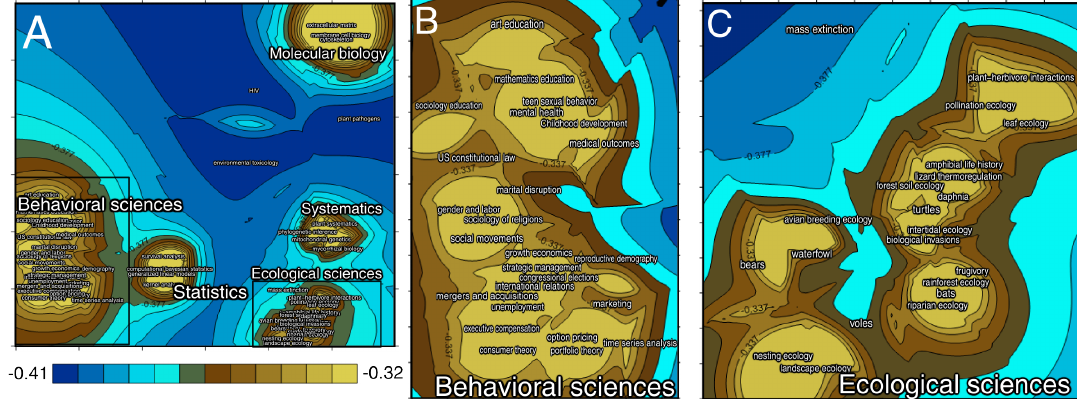
Figure 3: Topographical map of science combining textual and citation data. Fields that are close communicate frequently: positions in space are calculated by applying principal coordinate analysis to the matrix of shortest average citation paths and retaining the first and second principal coordinates. In this contour map, “oceans” (green shading to blue) represent the (negative of the) distance-weighted sum of symmetrized cultural holes between fields, ˜ C ij ; see “Data and Methods” for weighting function. Despite substantial citation flow between fields separated by these holes (e.g., survival analysis and medical outcomes), communication is inefficient. Note that social sciences cluster together on the left–hand side and biological sciences on the right–hand side, with statistics located between. Note also that molecular biology fields (upper right) are separated from other fields, including other biological sciences, by huge cultural holes, and that cultural holes sensibly separate the remaining fields (smaller panels). In the small panels, labels have been shifted slightly to reduce overlap and increase